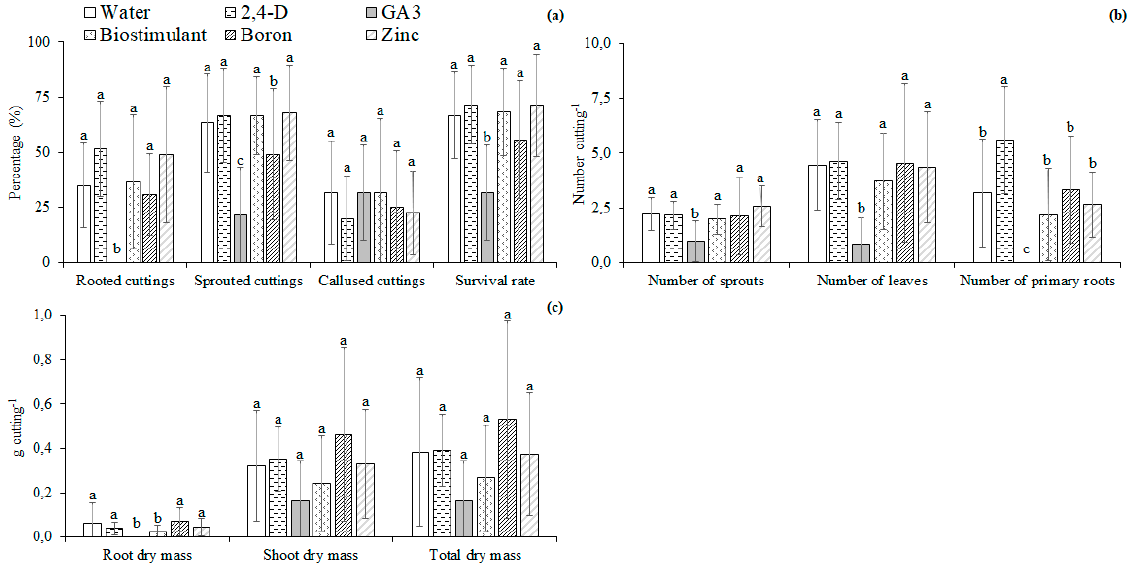
Figure 4. Percentage of rooted, sprouted, and callused cuttings, survival rate ( a ); number of sprouts, leaves, and primary roots ( b ); roots, shoots, and total dry matter ( c ) of Jatropha curcas L. hardwood cuttings immersed in distilled water or solutions of micronutrients or plant regulators at 77 days after planting. Different letters above each bar indicate significant differences among the immersion in water or solutions of micronutrients or plant regulators by the Least Significant Difference (LSD) test at the 5% probability level. Values are represented by the mean of four independent